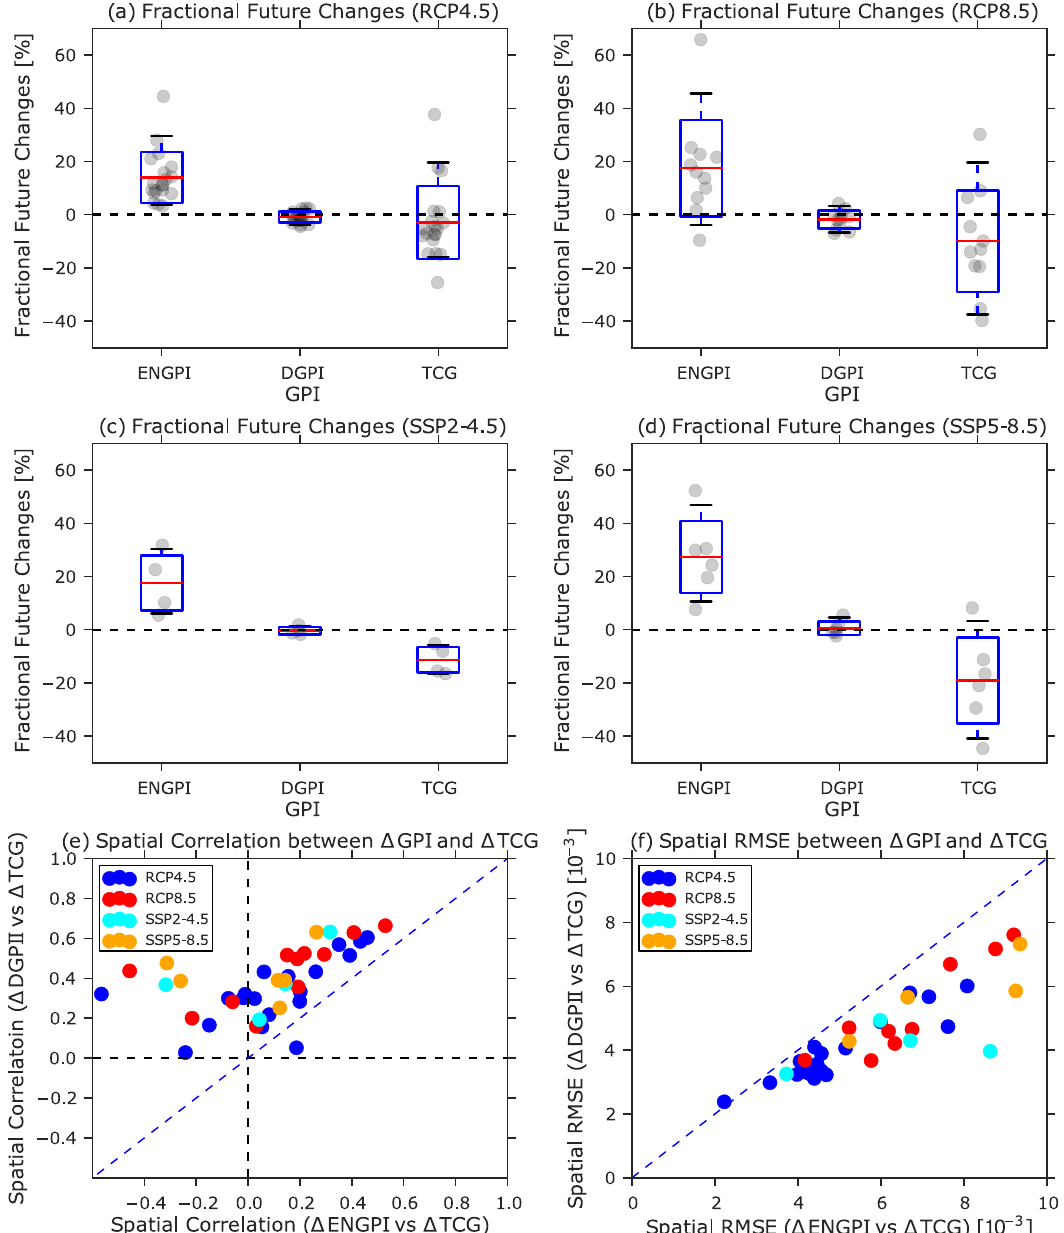
Fig. 3 Projected future changes in GPI and detected TCG frequency. The analyzed domain is in the tropics (30°S – 30°N) using the 19 CMIP5 models (19 models under RCP4.5 and 11 models under RCP8.5) and 6 CMIP6 models (4 models under SSP2-4.5 and 6 models under SSP5-8.5). The future change is determined by the reference between the future projection (2075 – 2099) and the historical simulations (1979 – 2003). a Box plot for future changes in GPI and TCG for RCP4.5. The boxes represent the range of the mean plus or minus one standard deviation of the intermodal spread in units of percentage changes, which represents the “ likely ” change. The horizontal red lines show the mean values, and the dashed bars show the 5% and 95% quantiles, representing the range of “ very likely ” change. b – d As in a , but for RCP8.5, SSP2-4.5, and SSP5-8.5 scenario, respectively. e Spatial PCCs between the future changes in ENGPI and TCG frequency ( x -axis) compared with those between DGPI and TCG frequency ( y -axis). The dots above the blue dashed diagonal line indicate that the spatial pattern of the changes in DGPI is closer to those in TCG than that in ENGPI. f As in e , but for RMSE. The dots below the blue dashed diagonal line indicate that the mean errors of DGPI are smaller than those of ENGPI in representing the TCG